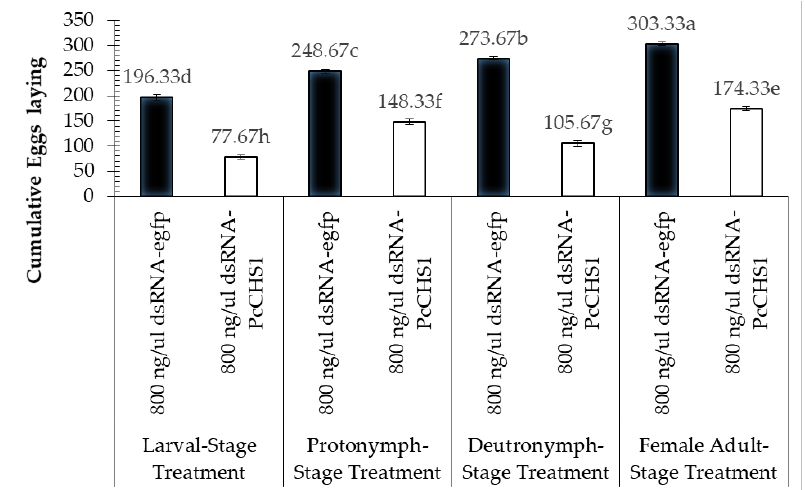
Figure 7. Fecundity of P. citri treated with the target gene dsRNA in di ff erent developmental stages. The values are the means of three independent replicates. The mortality response over time was analyzed by a repeated measures ANOVA, and significant di ff erences among the means were analyzed by a Fisher’s LSD test ( α = 0.05). Di ff erent small case letters on the bars showing significant di ff erence between the